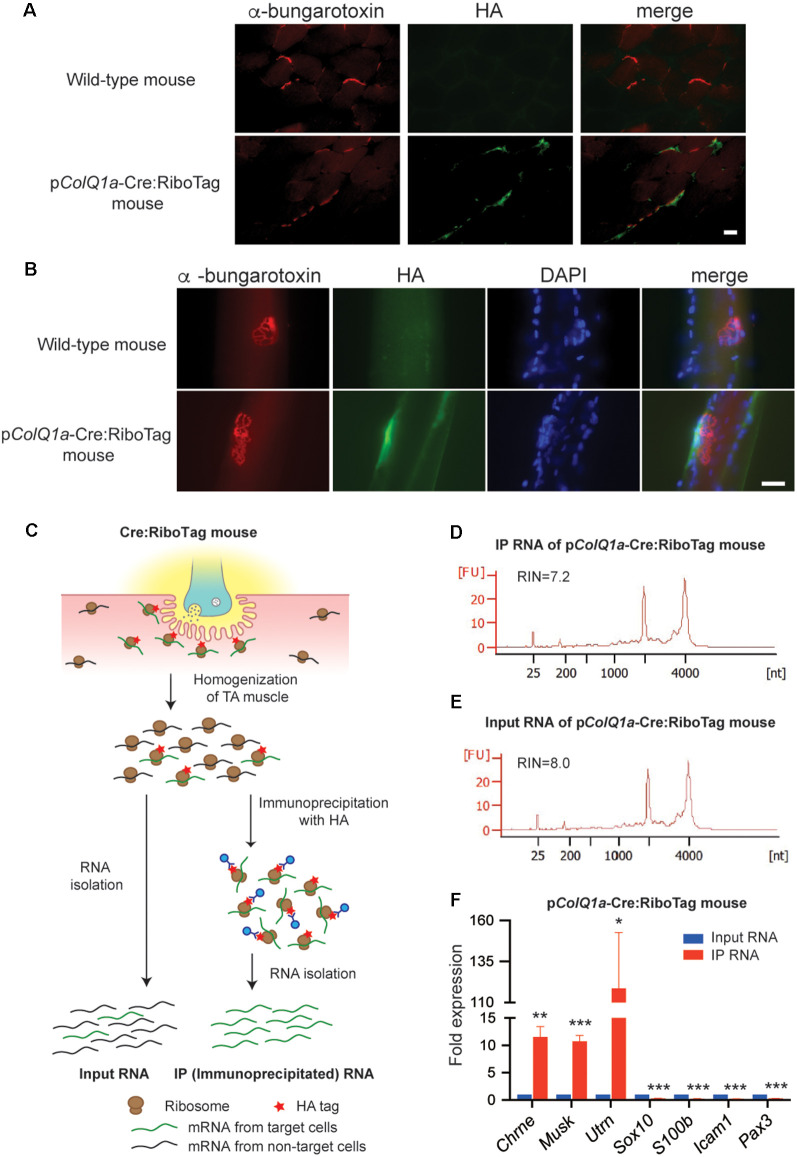
pColQ1a-Cre:Ribotag mouse to disclose a gene expression profile at the motor endplate TA muscle. (A,B) Immunofluorescence staining of TA muscle of wild-type and pColQ1a-Cre:RiboTag mice. Muscle sections (A) and teased muscle fibers (B) are stained with anti-HA antibody (green) and Alexa594-conjugated α-bungarotoxin 594 (red). Nuclei are stained with DAPI. Scale bar = 15 μm. (C) Schematic of the RiboTag technique for gene expression profiling at the motor endplate of TA muscle. (D,E) Agilent Technologies 2100 Bioanalyzer PicoChip outputs showing the quality of immunoprecipitated (IP) RNA (D) and input RNA (E). (F) qRT-PCR of NMJ-specific Chrne, Musk, and Utrn genes, Schwann cell-specific Sox10 and S100b, vascular endothelial cell-specific Icam1, and muscle satellite cell-specific Pax3. Gene expression level in IP RNA was normalized to that of Gapdh, and also to the ratio in input RNA. TA muscles of 10, 11, 12, and 16 pColQ1a-Cre:Ribotag mice were pooled into four independent samples, and were analyzed in quadruplicate (n = 4). Mean and SD is indicated. *p < 0.05, **p < 0.01 and ***p < 0.001 by paired Student’s t-test.